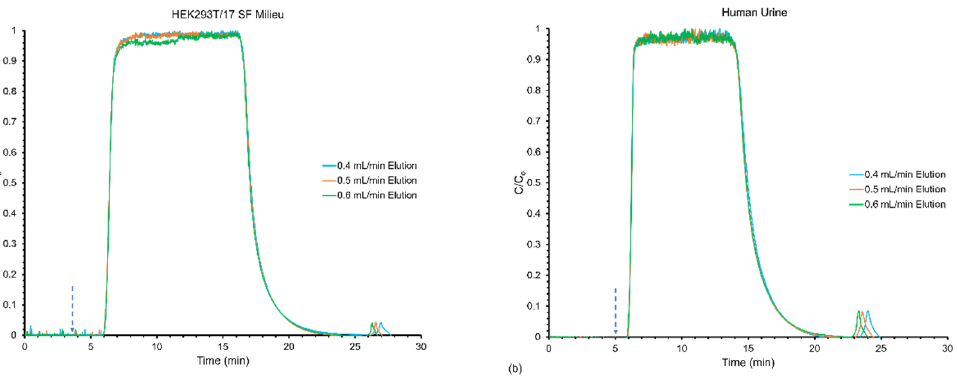
Figure 4. Frontal loading response for the effect of varying the elution flow rate from 0.4–0.6 mL min − 1 while maintaining the loading flow rate at 0.5 mL min − 1 for ( a ) HEK293T/17 SF Milieu and ( b ) human urine samples. Table 3. The effect of varying loading and elution flow rates on the loading, recovery, throughput, and yield of EVs isolated from HEK293T/17 SF milieu and human